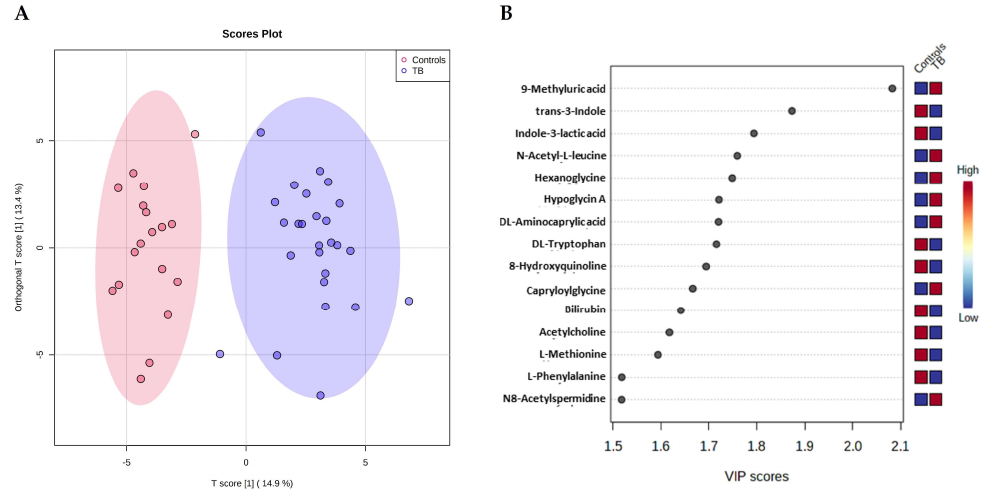
Figure 5. OPLS-DA model based on the metabolites quantified by LC-MS discriminates TB patients from the control group. ( A ) Score plot of the OPLS-DA model shows a clear discrimination between the serum metabolites levels of patient and control groups (Q 2 = 0.733, permutations (2000) p < 0.001). Areas in red and blue represent the 95% confidence region. Dots represent the replicates for each condition (n(control) = 18 and n(TB) = 25). ( B ) The metabolites that are important for the discrimination between the two groups (VIP > 1.5 in the first component).